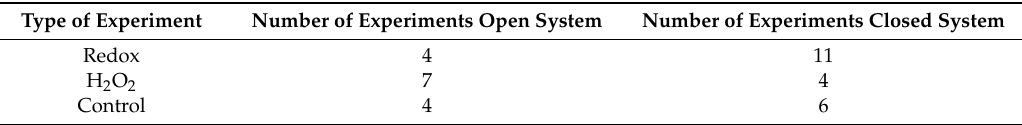
Table 1. Number of time series of Raman spectra for analysis. Type of